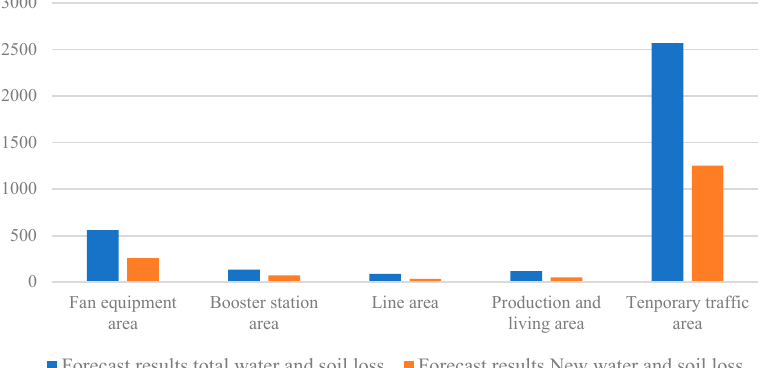
Figure 14. Distribution of water and soil loss in the predicted areas.